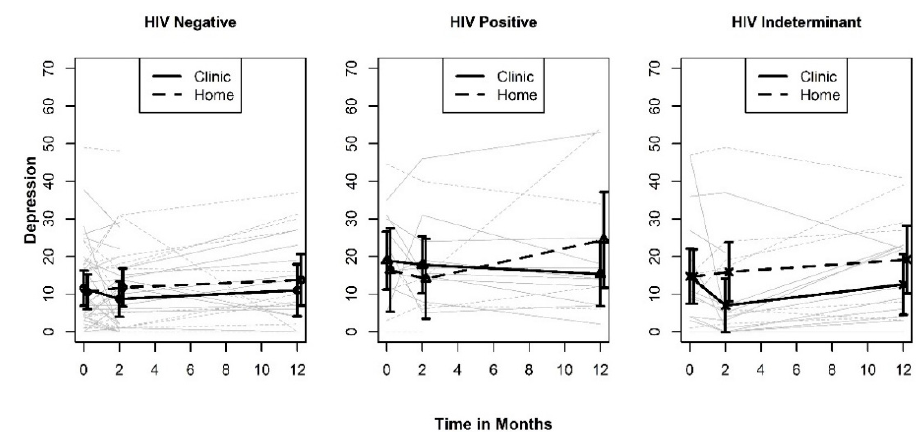
Figure 5. Plots of depression by HIV test result .